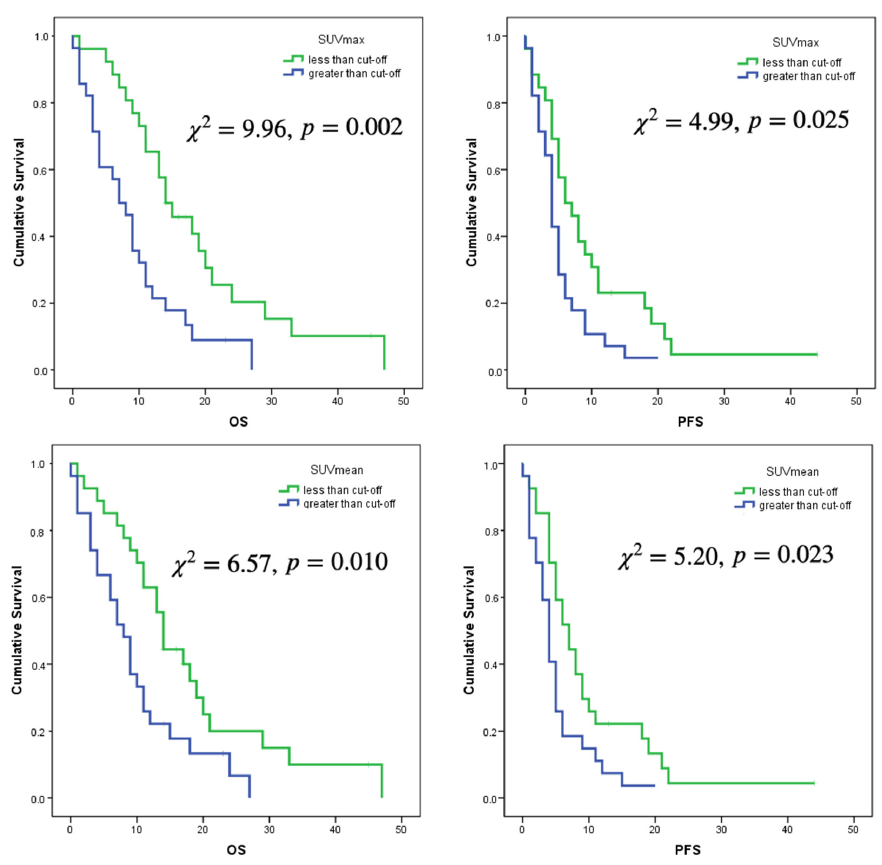
Figure 3. Log rank curves for OS and PFS for a cut-off of SUVmax of 3.56 and a cut-off of SUVmean of 1.25.